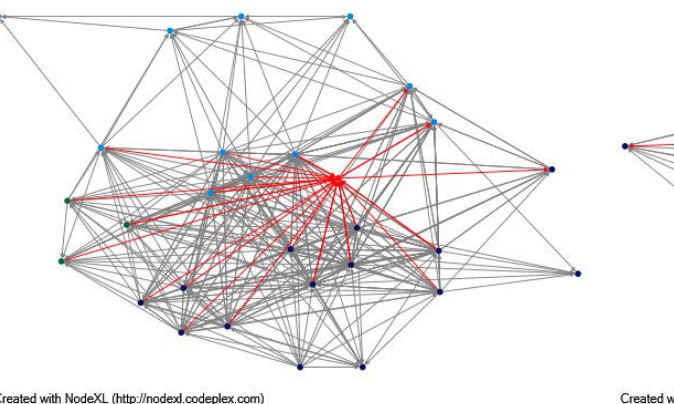
Figure 3b. An egocentric network of “gradually mastering member” becoming a “recognized member” (final four